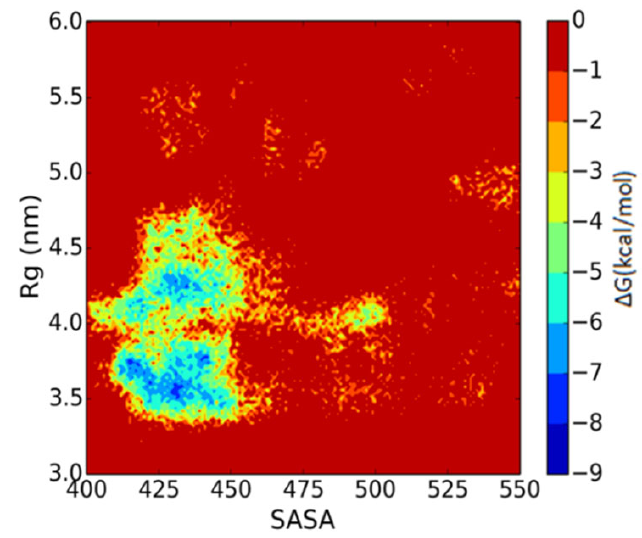
Figure 3. Free energy maps vs. two reaction coordinates, the Rg and SASA.